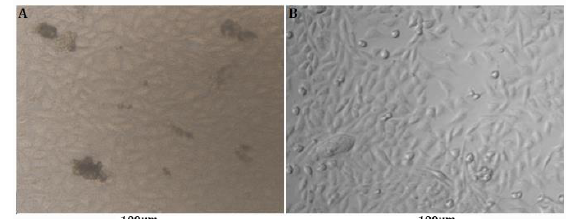
Figure 5. Viability of T47D cells after treated by